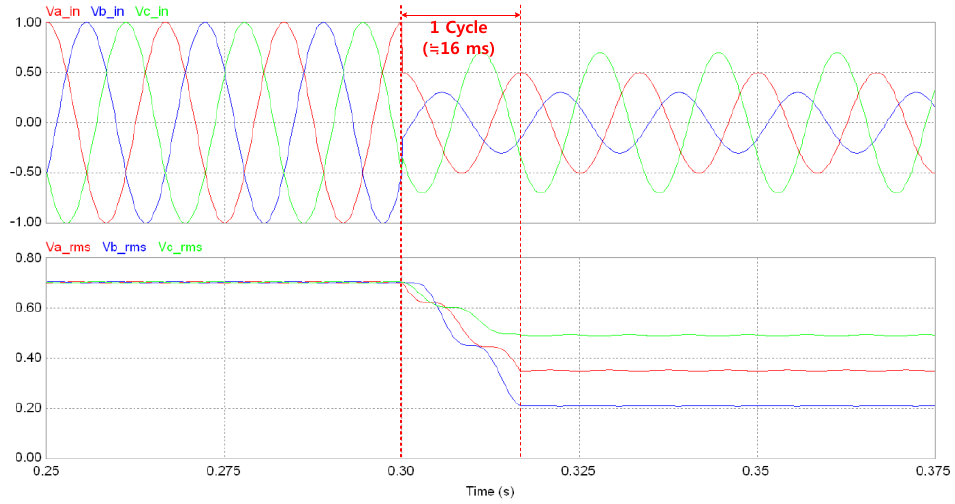
Figure 4. Simulation results of the conventional method: the grid voltage ( top ) and the measured RMS value of the fundamental component ( bottom ).